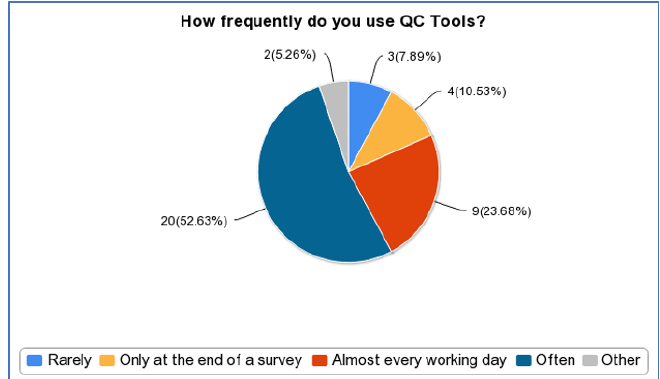
Figure 18. Customer satisfaction survey on QC Tools: frequency of use. Of the 39 survey respondents, more than 75% use QC Tools “often” or “almost every single working day” (more details are available in [6] ).